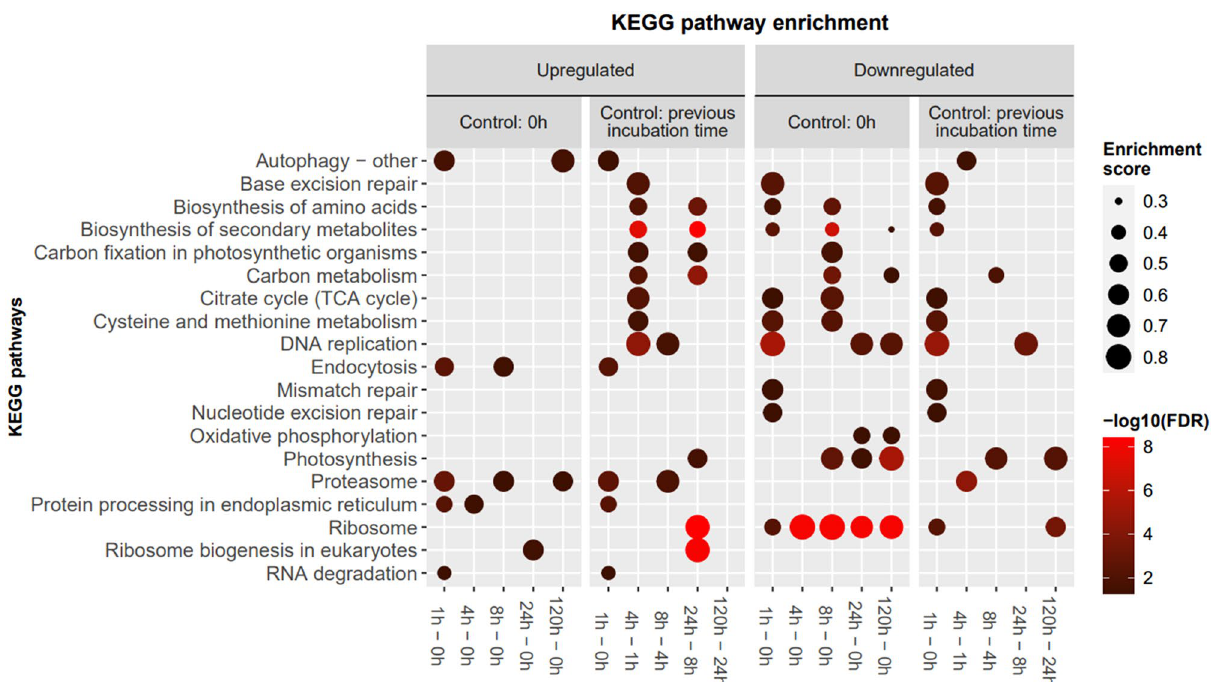
Figure 5. Pathway enrichment analysis of the mRNA expression response of Picochlorum sp. (BPE23) at each cultivation time after an increase in temperature from 30 to 42 °C. The dot size indicates the enrichment score of the KEGG pathway whereas the color brightness indicates significance (− log 10